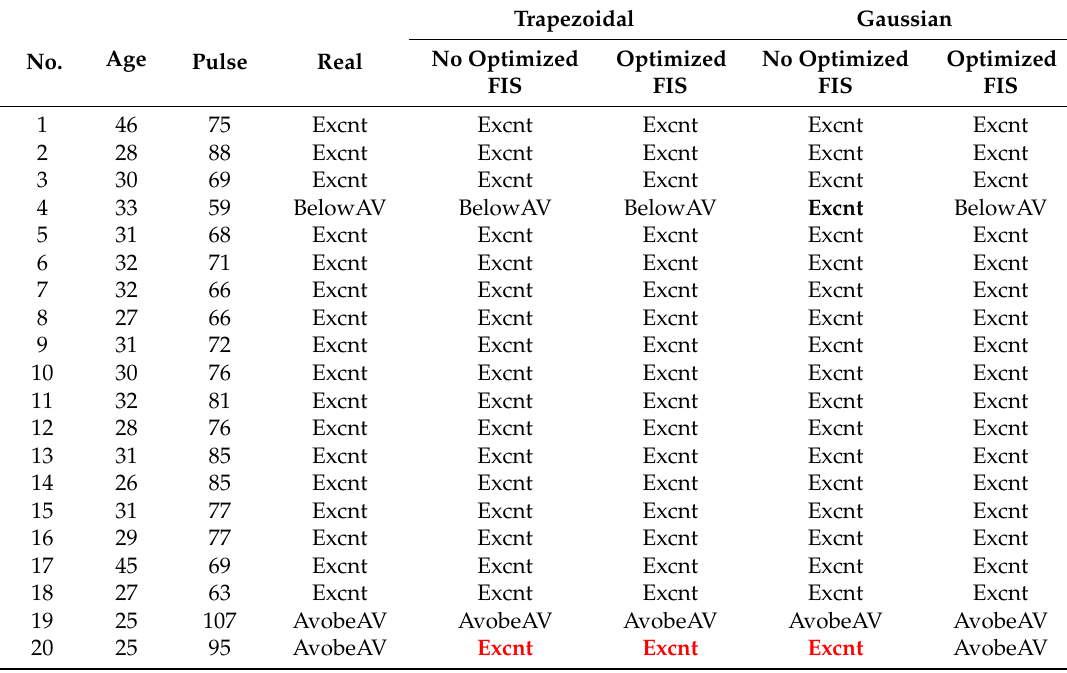
Table 13. Test with real